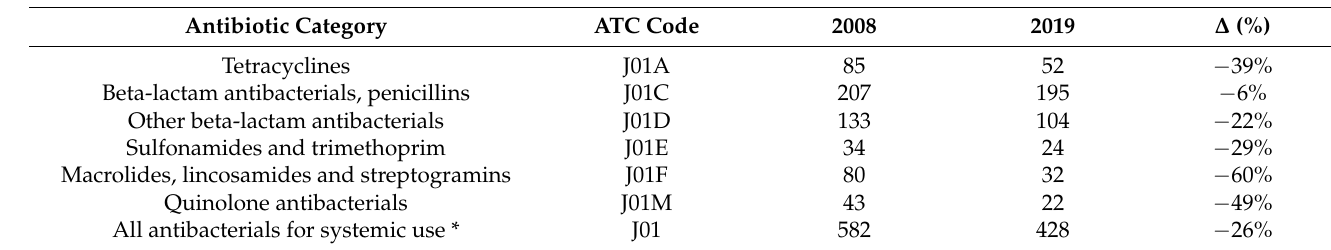
Table 1. Changes in antibiotic prescription rate per 1000 adults by antibiotic category (ATC-codes) between the years 2008 and 2019. Prescription Rate (Number of Prescriptions/1000 Adults/Year) ATC